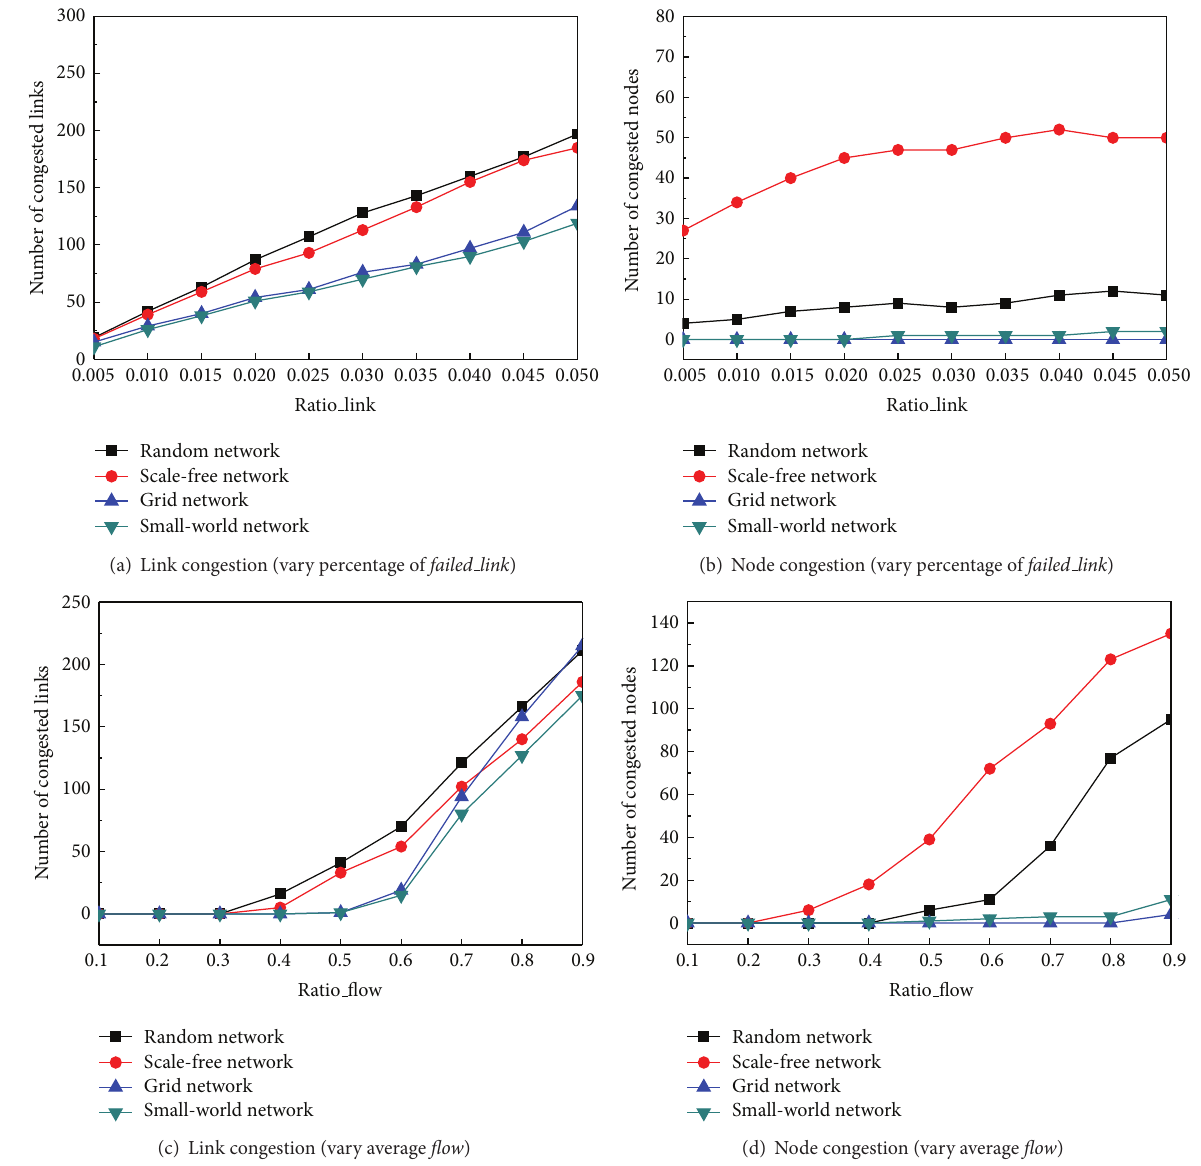
Figure 2: Congestions from link failure recovery by varying Ratio link and Ratio flow